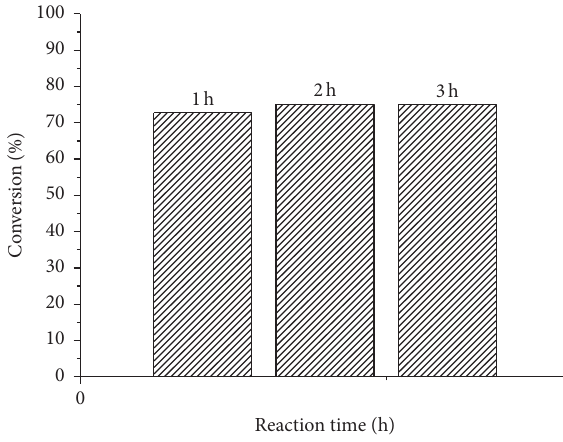
Figure 12: The influence of reaction time on esterification reaction.